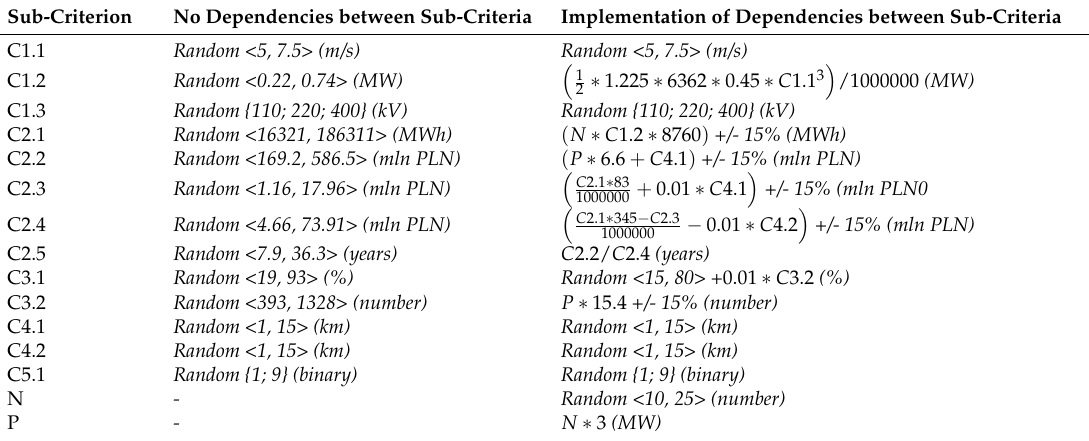
Table 11. The way of generating the alternative A5 which does not take into consideration and considers dependencies between sub-criteria.